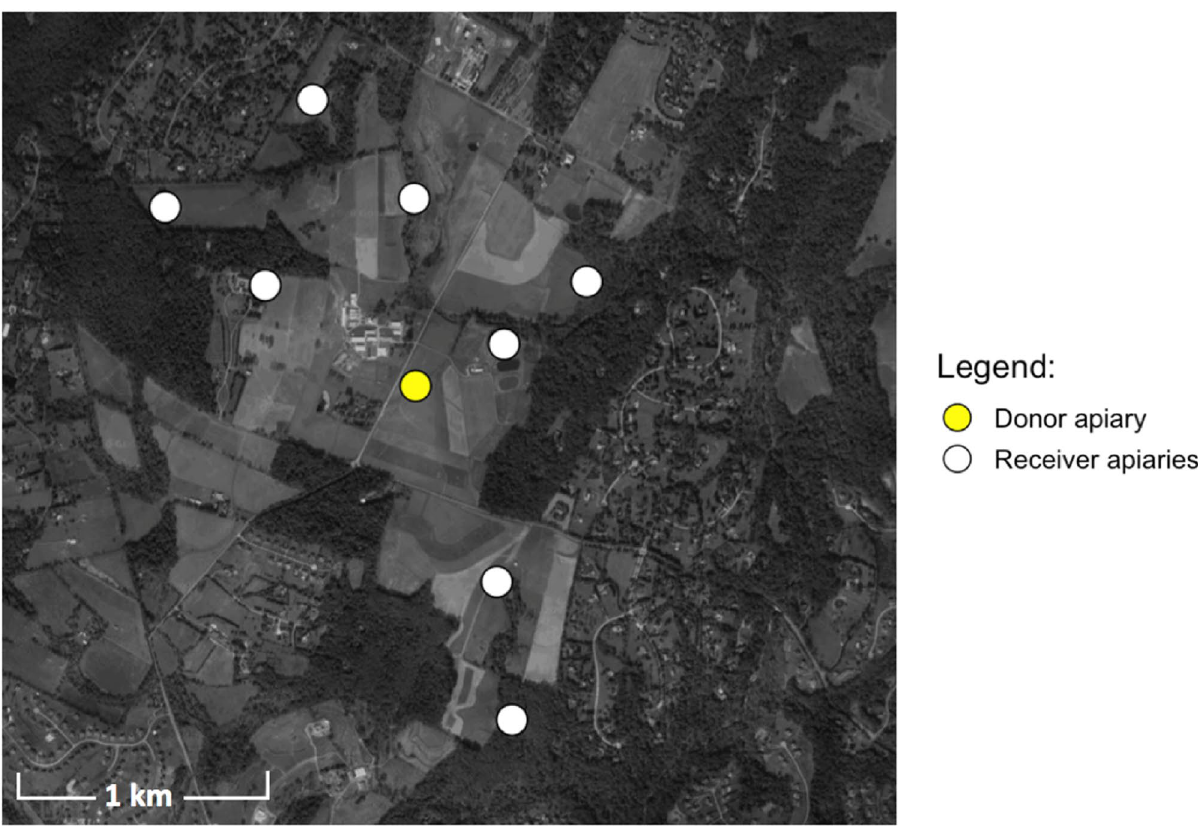
Figure 1. Map of donor and receiver apiary locations. Map produced with R version 3.3.3 (https:// www.r- proje ct.